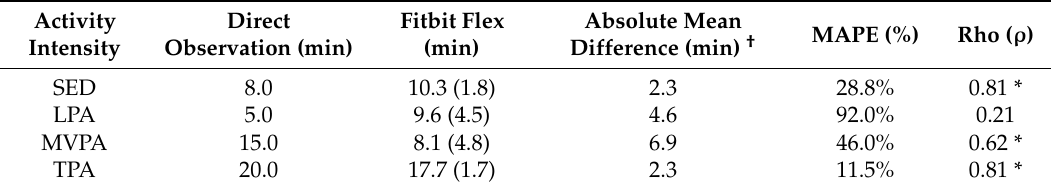
Table 3. Estimated means (SD), absolute mean difference, mean absolute percent error, and Spearman correlation coefficients between direct observation and the Fitbit